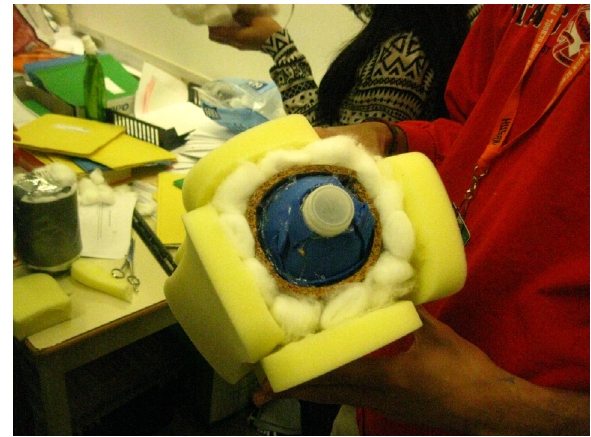
Figure 8. Example of the use of materials for building the thermos.